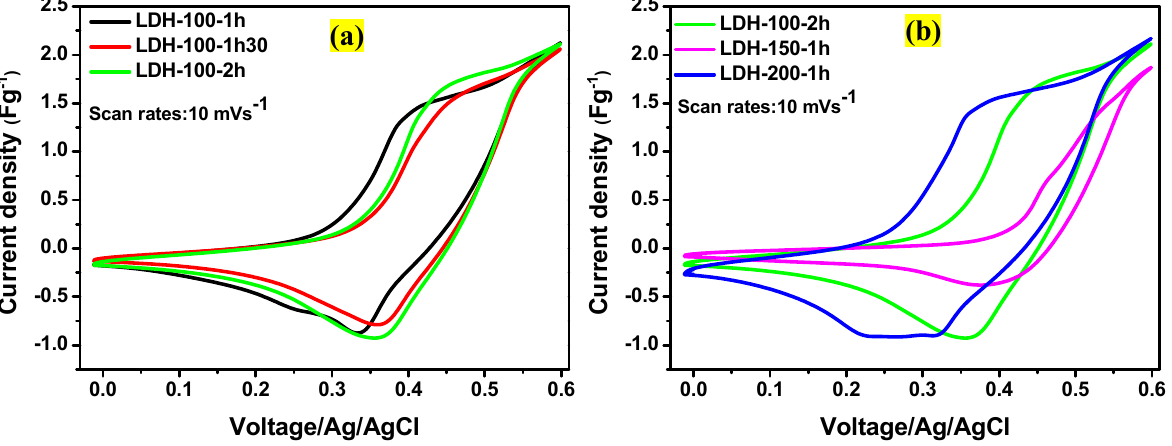
Figure 5. ( a ) Comparative CV curves for the LDH-100-1h, LDH-100-1h30, and LDH-100-2h electrodes at a scan rate of 10 mVs −1 ; ( b ) comparative CV curves for the LDH-100-2h, LDH-150-1h, and LDH-200-1h electrodes at a scan rate of 10 mVs −1 .